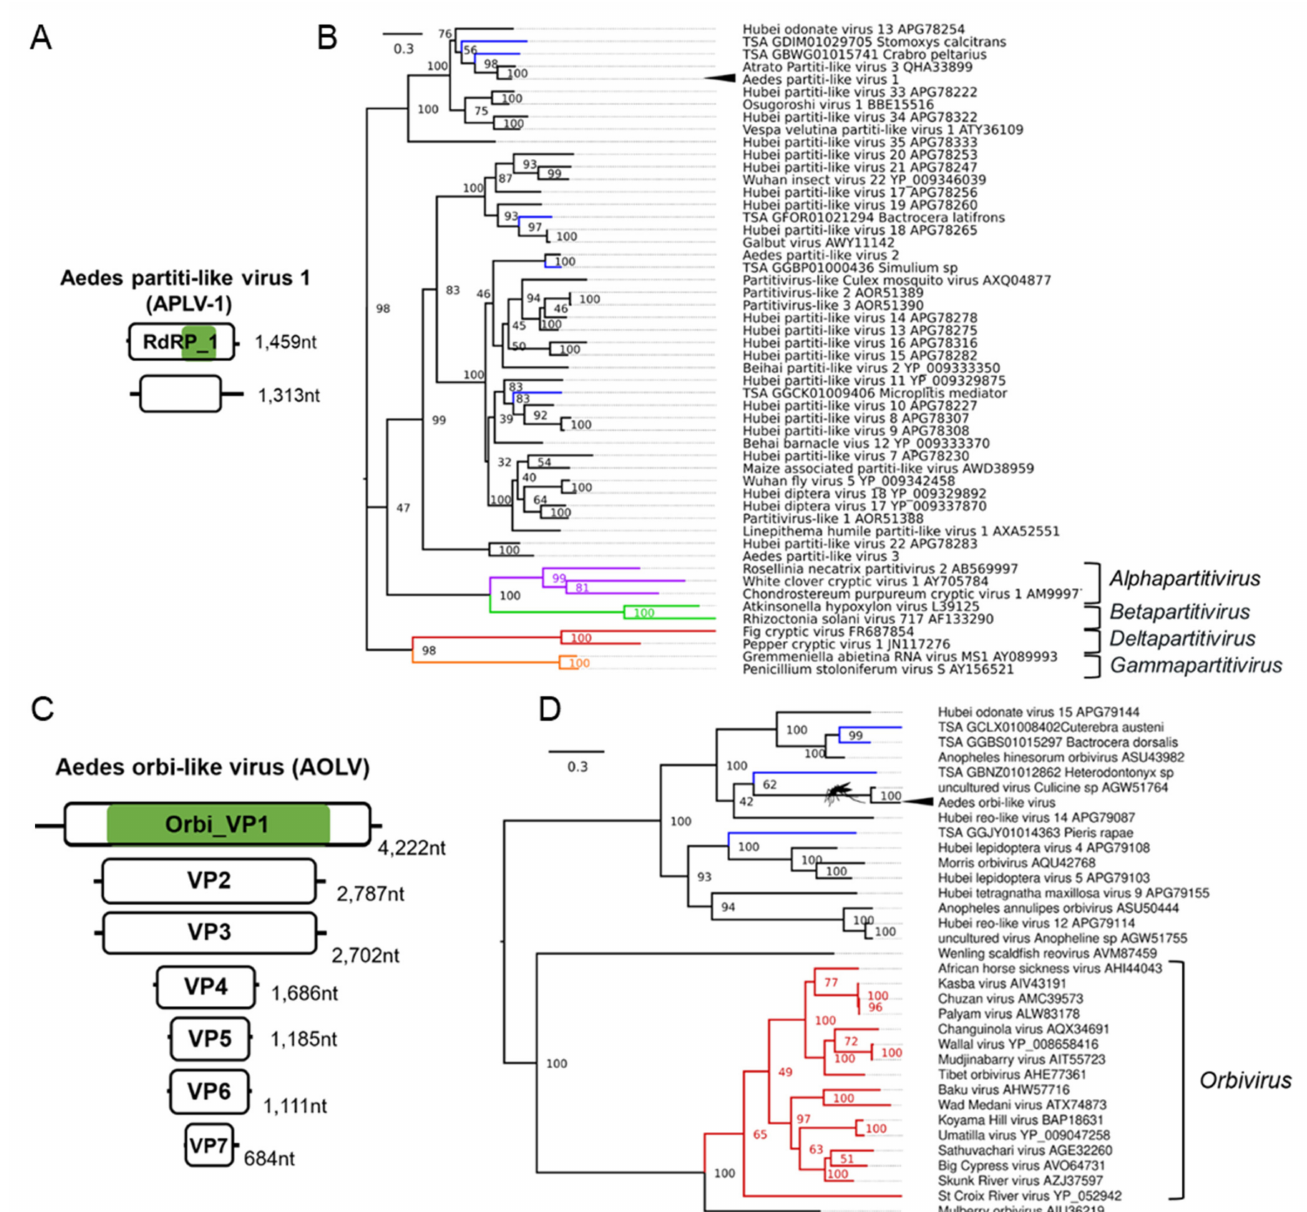
Figure 6. Novel dsRNA viruses of Ae. aegypti . Genome organisation ( A ), and phylogenetic placement ( B ) of Aedes partiti- like virus 1 (APLV-1) within the Partitiviridae family based on RdRp_1 domain alignment. ICTV accepted genus members from Alphapartitivirus (purple), Betapartitivirus (green), Deltapartitivirus (red), and Gammapartitivirus (orange). ( C ) Genome organisation of Aedes orbi-like virus (AOLV), and ( D ) phylogenetic position of AOLV based on aligned VP1 RdRp domain within the Reoviridae family. Members of the Orbivirus genus are indicated in red. Consensus maximum-likelihood trees were made with IQTree under the LG + G4 amino acid substitution model with 50,000 Ultrafast bootstraps. For clarity, the tree is midpoint rooted. Each TSA accession is shown in blue. Novel viruses are indicated with arrowheads. Nodes with an adjacent mosquito indicate virus clades identified from mosquito species. Branch length indicates the number of amino acid substitutions per